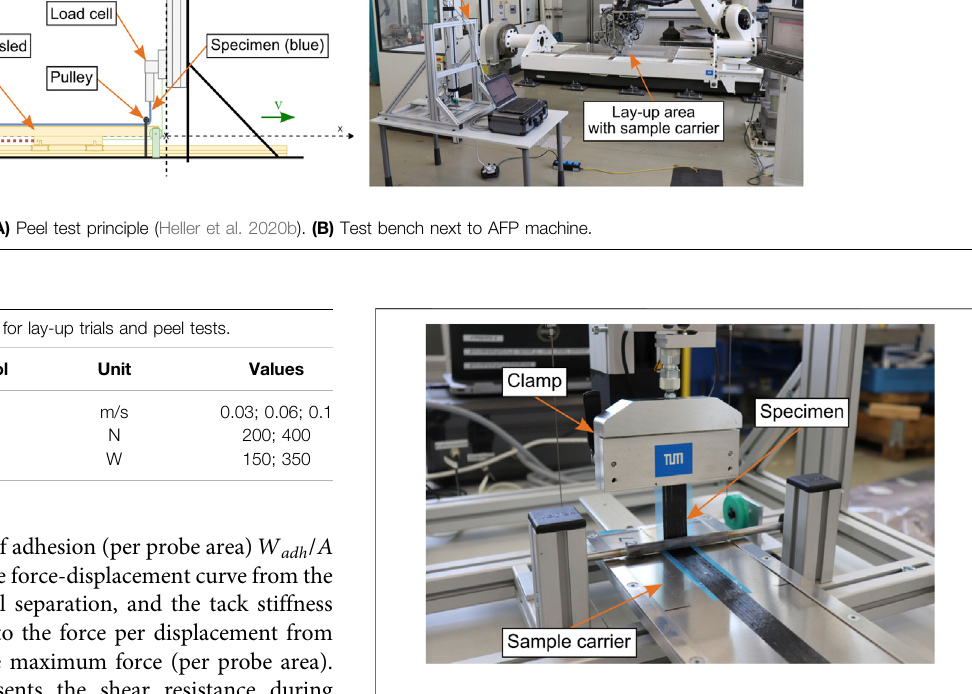
FIGURE 4 | Peel tack test — clamped